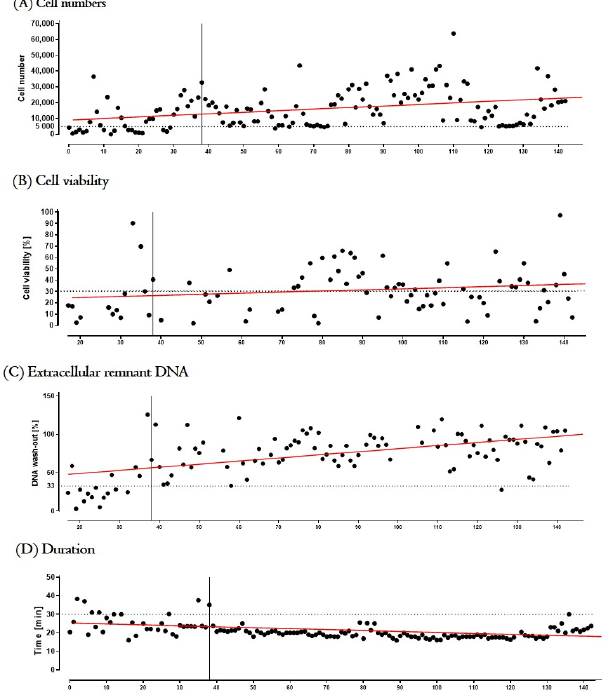
Figure 5. Effect of training on manufacturing of tIPE. Productions (n = 143) were analyzed to define the training necessary to manufacture a tIPE with optimal cell numbers isolated from a biopsy ( A ), cell viability ( B ), least contamination with remnant extracellular DNA ( C ), as well as time of manufacture of tIPE ( D ) routinely. The dashed lines present the lower limit of the release criteria (5000 cells, 33% remnant extracellular DNA, 30 min) or guidance level (30% viability). The vertical lines illustrate the end of the training phase and start of the ValRun (after 39 productions). ( A ) The number of isolated cells increased significantly over time even after the training period. ( B ) Cell viability increased over time, but the increase was not statistically significant. ( C ) Remnant extracellular DNA determined in the supernatants of tIPE improved significantly over time. ( D ) Manufacture duration was significantly shortened by training.